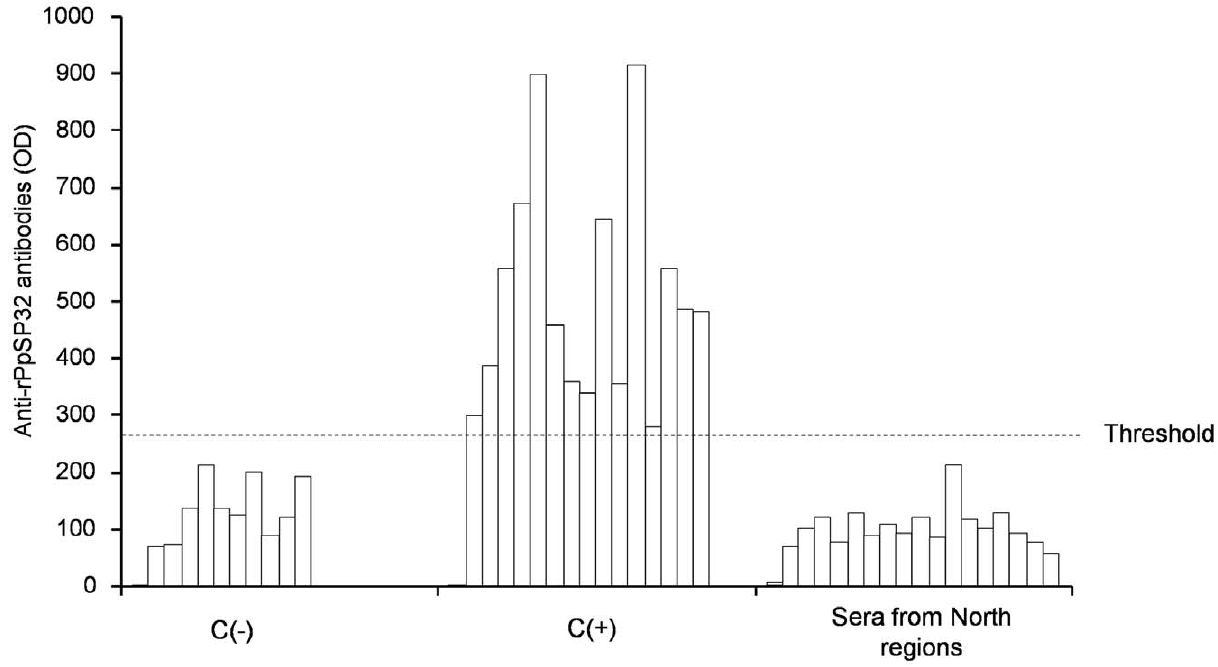
Figure 8. Specificity of rPpSP32 ELISA test towards P.papatasi species. Twenty sera obtained from donors living in the North regions of Tunisia where P. pernicious is prevalent and P. papatasi is absent were tested by ELISA using rPpSP32. Ten negative sera (C 2 ) and fifteen positive sera (C + ) from donors living in the regions where P. papatasi is prevalent were also included. The threshold of positivity was the mean optical density (OD) of negative controls plus 3 standard deviations.